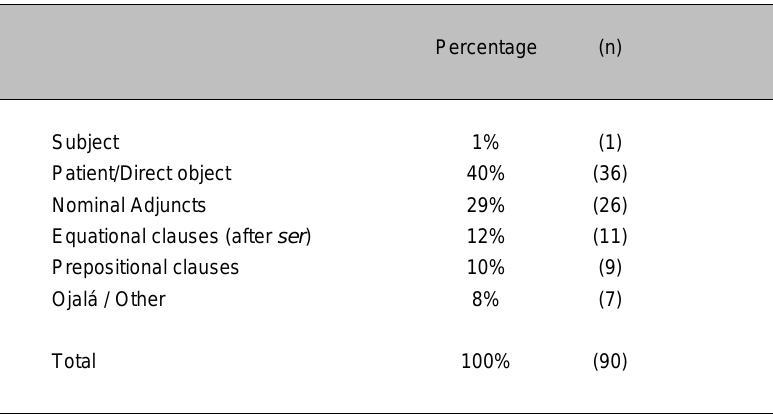
Table 3: Argument functions of the nominal subordinate with intrusive que in the main